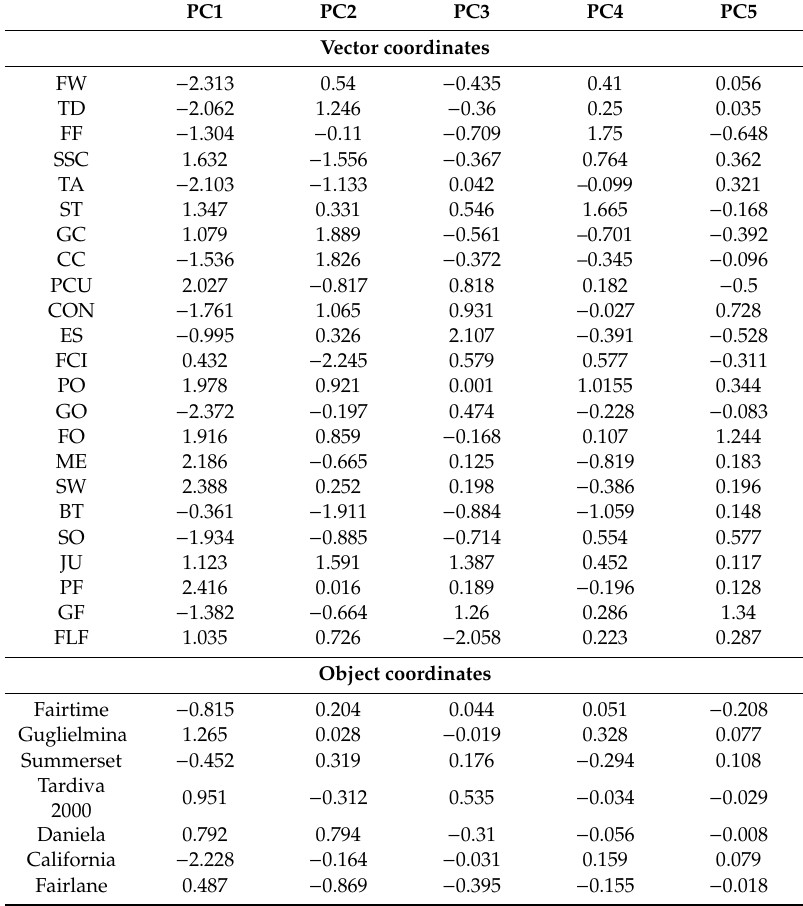
Table 5. Standardized component coordinates for quality attributes (vectors) and cultivars (objects) from biplot analysis and grouping by cluster analysis (FW, fresh weight; TD, transversal diameter; FF, flesh firmness; GC, ground color index; SSC, soluble solid content; TA titratable acidity; ST, SSC / TA; PCU, peel color uniformity; CON, consistency; ES, easy stone; FCI, Flesh color intensity; PO, peach odor; GO, grass odor; FO, flower odor; ME, mealiness; SW, sweetness; BT, bitterness; SO, sourness; JU, juiciness; PF, peach flavor; GF, grass flavor; FLF, flower flavor). Peach (five cultivars) and nectarine (two cultivars) trees (500 / ha) were grown near Riesi (37 ◦ 16 (cid:48) N and 330 m a.s.l.), in central–southern Sicily. PC1